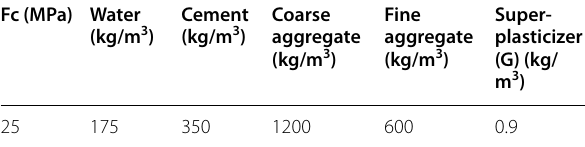
Table 2 Concrete mix proportions for the control